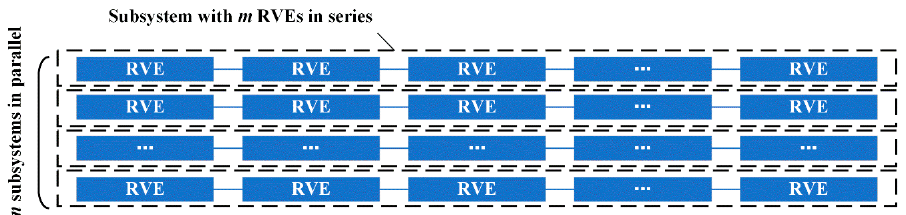
Figure 4. Series-parallel model of the CFRP used in the strengthen scheme.